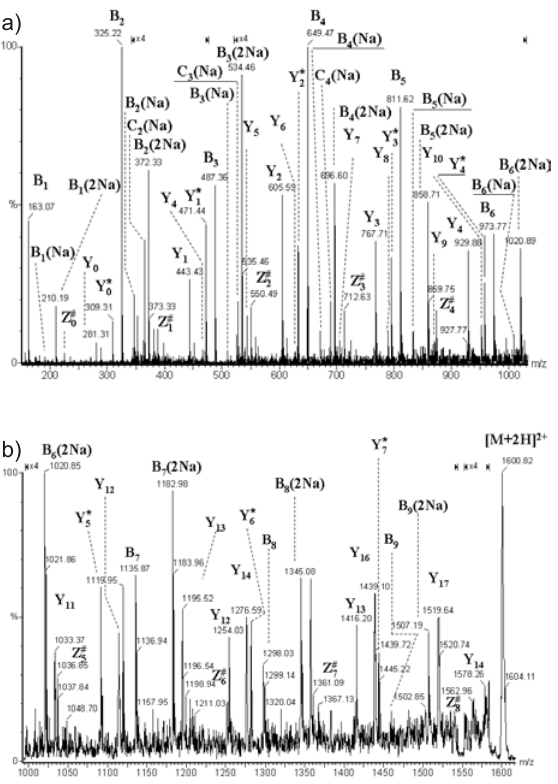
Figure 5. Positive nanoESI Q-TOF MS/MS of the doubly charged ion at m/z 1600.82 detected in HMD-modified maltodextrin sample. a) m/z (150 - 1020); b) m/z (1000 - 1600). Capillary voltage: 1.2 kV. Cone voltage: 50 V. CID at variable collision energy (E ) within 40-70 eV. lab